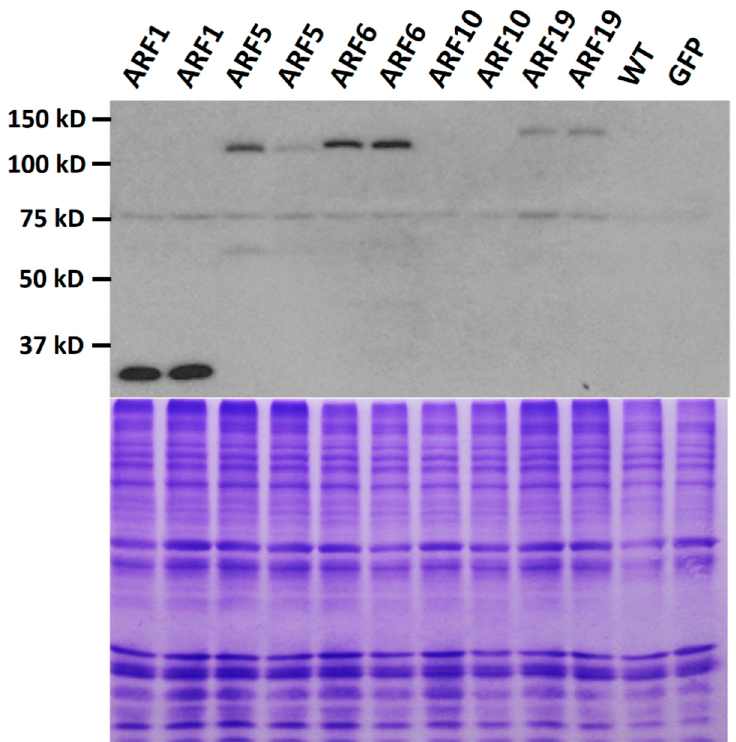
Figure 1. Analysis of HA-ARF protein expression in primary Arabidopsis transformants. Arabidopsis plants were transformed with the HA-tagged ARF constructs. Each protein sample was prepared from a pool of 25 non-selected independent transformants, as well as the control plants, to represent an average expression level for the particular construct. For each construct, two replicate samples were prepared. The protein samples were used for electrophoresis and the HA-ARF fusion proteins were detected by western blotting using an anti-HA antibody. Upper panel: western blotting image, with protein molecular weight markers indicated at the left. There is a weak non-specific band present in all samples. Lower panel: image of the gel stained with Coomassie blue to show the amount of samples loaded.